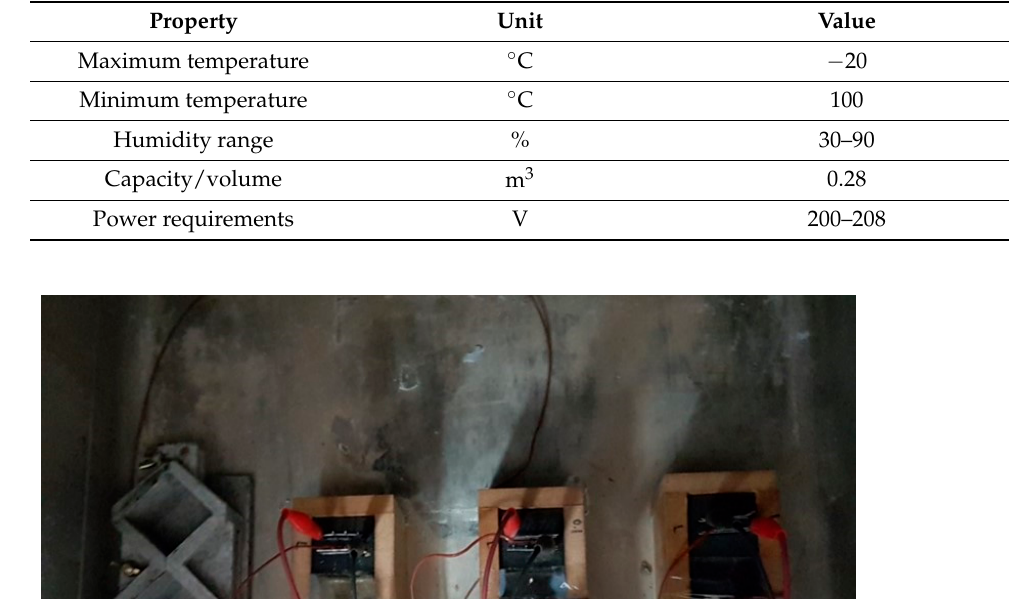
Table 2. Chamber specifications.